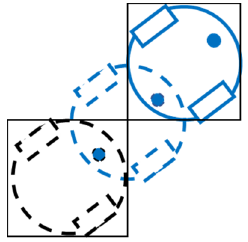
Figure 2. Robot lies in the middle of spots and moves in a diagonal line.